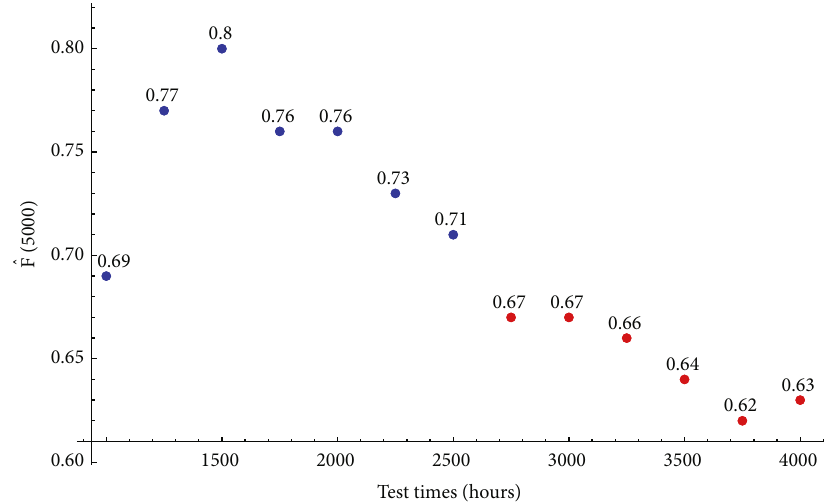
Figure 12: Failure probability estimates for di ff erent test